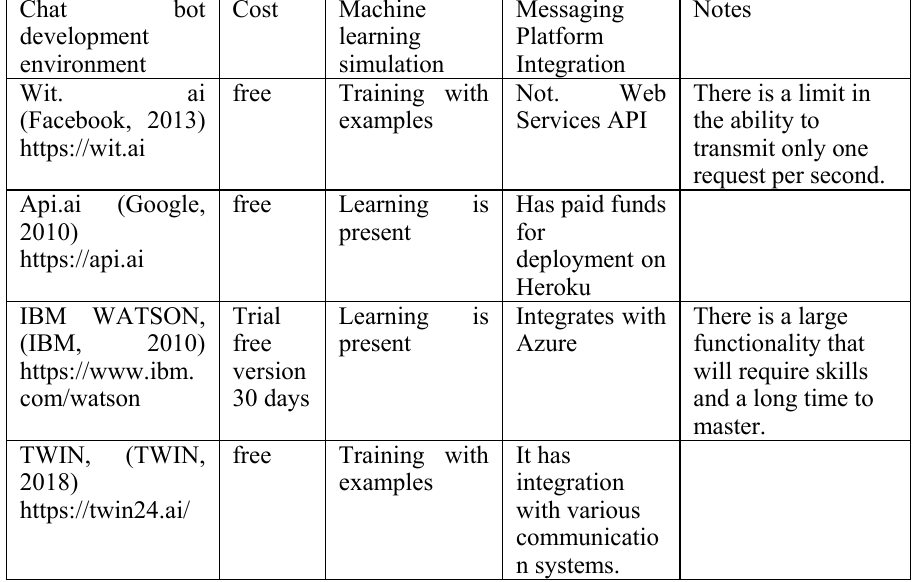
Table 1. Overview of platforms for building voice and chat